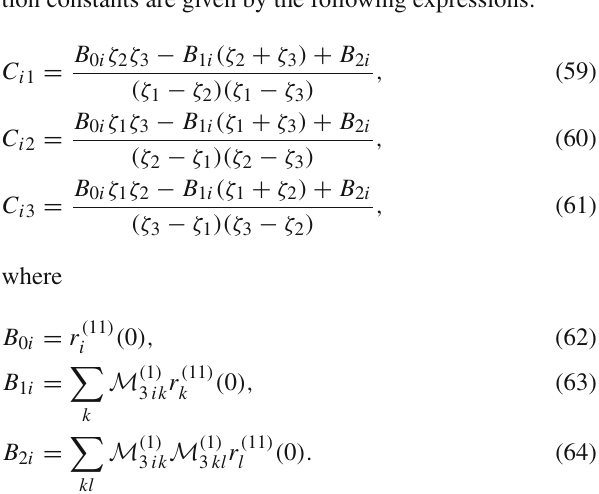
Fig. 2 The real root of the cubic equation (65) as a function of the reduced frequency ¯ ω B for particular values of the angle β . Each β is characterized by the asymptotic value of ζ 3